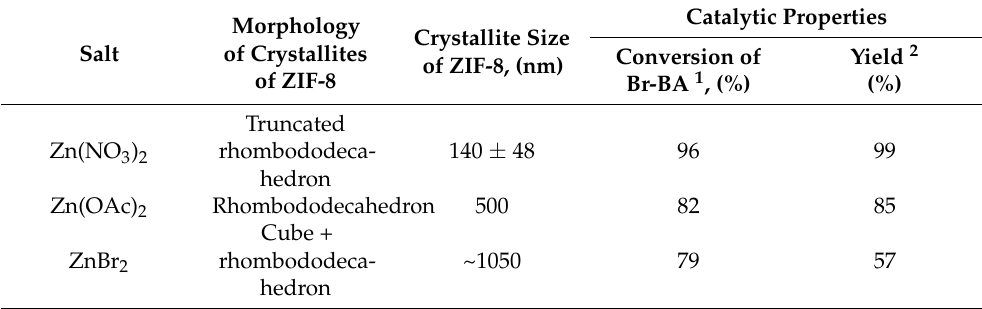
Table 4. Influence of the nature of zinc salt on the morphology, particle size, and catalytic properties of